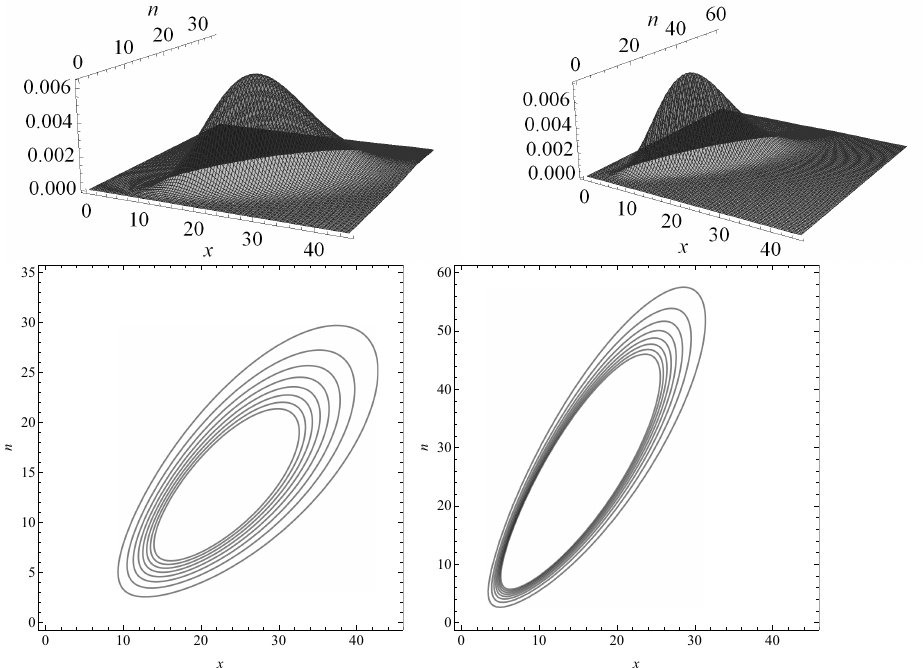
Figure 1. Graphs of the density for the bivariate distribution f ( x , n ) in (14) and the corresponding contour plots for different values of the parameters. Left panel ( γ , µ 1 , µ 2 ) = ( 0.5,25,15 ) and right panel ( γ , µ 1 , µ 2 ) = ( 0.65,15,25 )